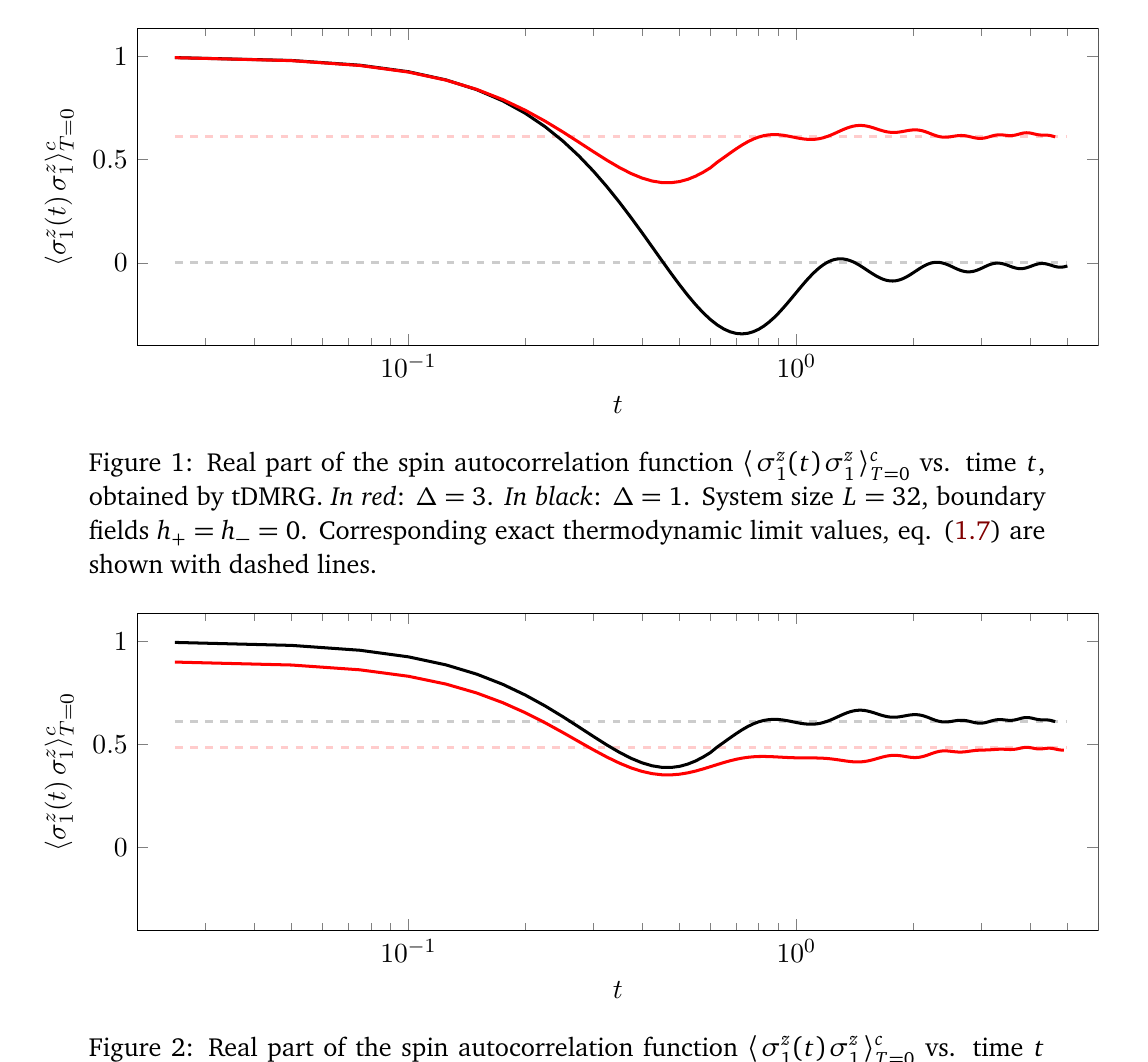
Figure 2: Real part of the spin autocorrelation function 〈 σ z obtained by tDMRG. In black : h ± = 0. In red : h ± = 1. System size L = 32, anisotropy ∆ = 3. Corresponding exact thermodynamic limit values from eq. (1.6) and eq. (1.7) are shown